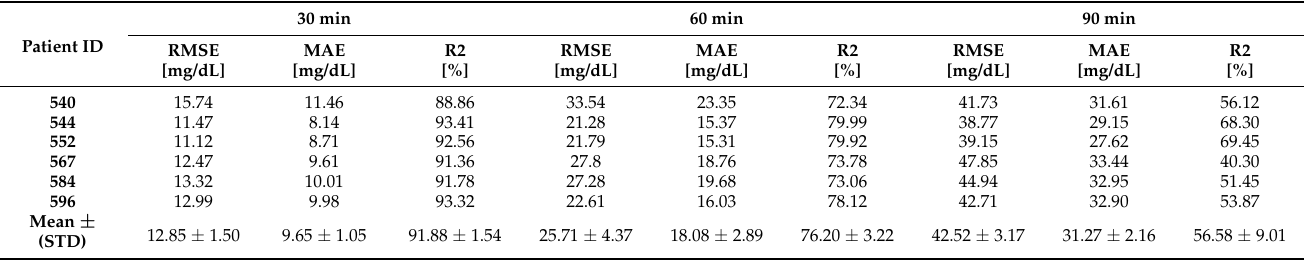
Table 4. Patient-wise analysis results with LSTM model, given scenario 7. MAE, RMSE and R2 of BG prediction for personalized training for each patient separately, for 30 to 90 min